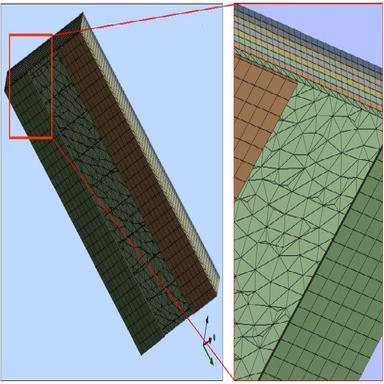
The actual generated mesh of the 8-ply TEG-enabled CFRP laminate, with 10 thermocouples in the bottom lamina. The different discretization domains are evident both at the low (left hand-side), as well as the high (right hand-side) magnification images.